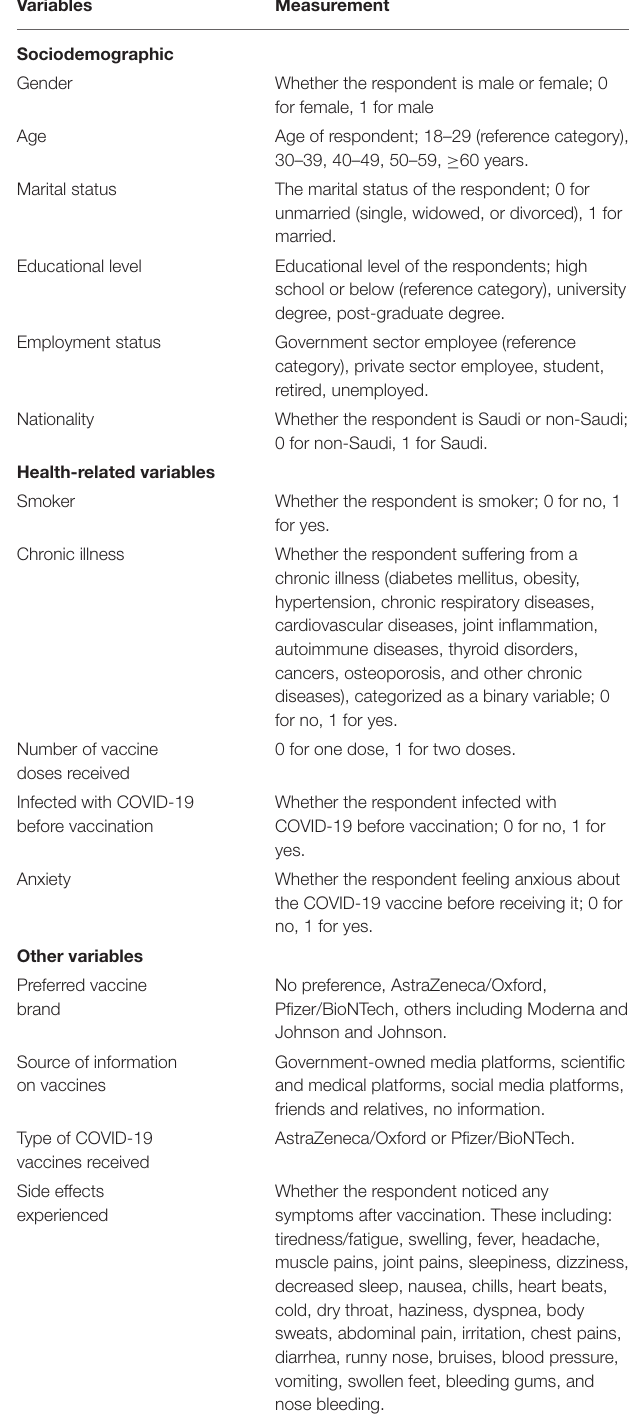
TABLE 1 | Independent variable